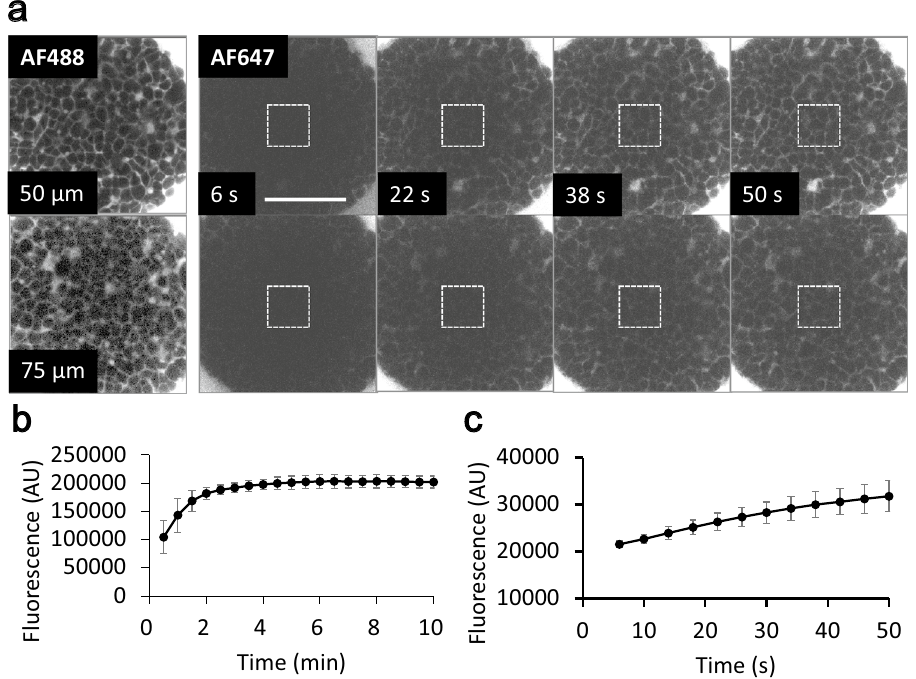
Figure 2. Measurement of the inflow diffusion rate of AF647 in HepG2 spheroid cores. ( a ) A single spheroid was visualized with NCI by addition of AF488 as an indicator to set the position of confocal microscopy scanning (left). Then AF647 was added into the medium, and scanned at distances of 0, 25, 50 and 75 µm from the adhesion plane at 4 s intervals for 50 s. The gain in fluorescent intensity at the deeper spheroid core (75 µm) was lower than that of the shallow core (50 µm). Dashed rectangles indicate the area for quantity fluorescent intensity. Bar: 100 µm. ( b , c ) Graph of changing the fluorescent intensity over long ( b ) and short ( c ) periods at a distance of ( b ) 70 µm or ( c ) 75 µm from the adhesion plane of the target spheroid. N = 3 ( b ) or 5 ( c ). Within 5 min, the fluorescence of the core reached a